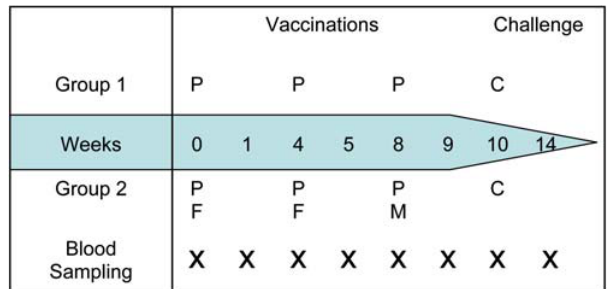
Figure 1. Study Design. P=Vaccination with PEV3A, F=Vaccination with FP9 ME-TRAP, M=Vaccination with MVA ME-TRAP, C=Sporozoite challenge